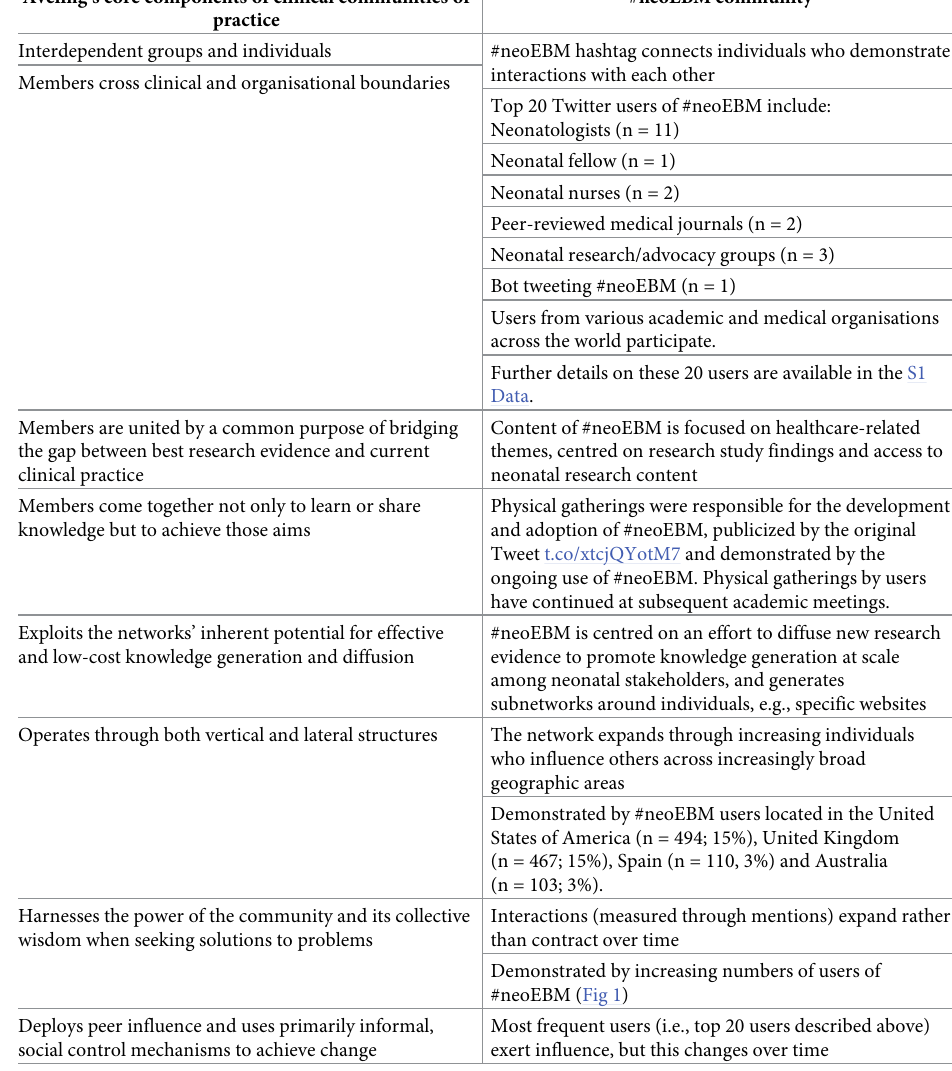
Table 1. Aveling’s core components of clinical communities of practice and alignment with the #neoEBM community. Aveling’s core components of clinical communities of